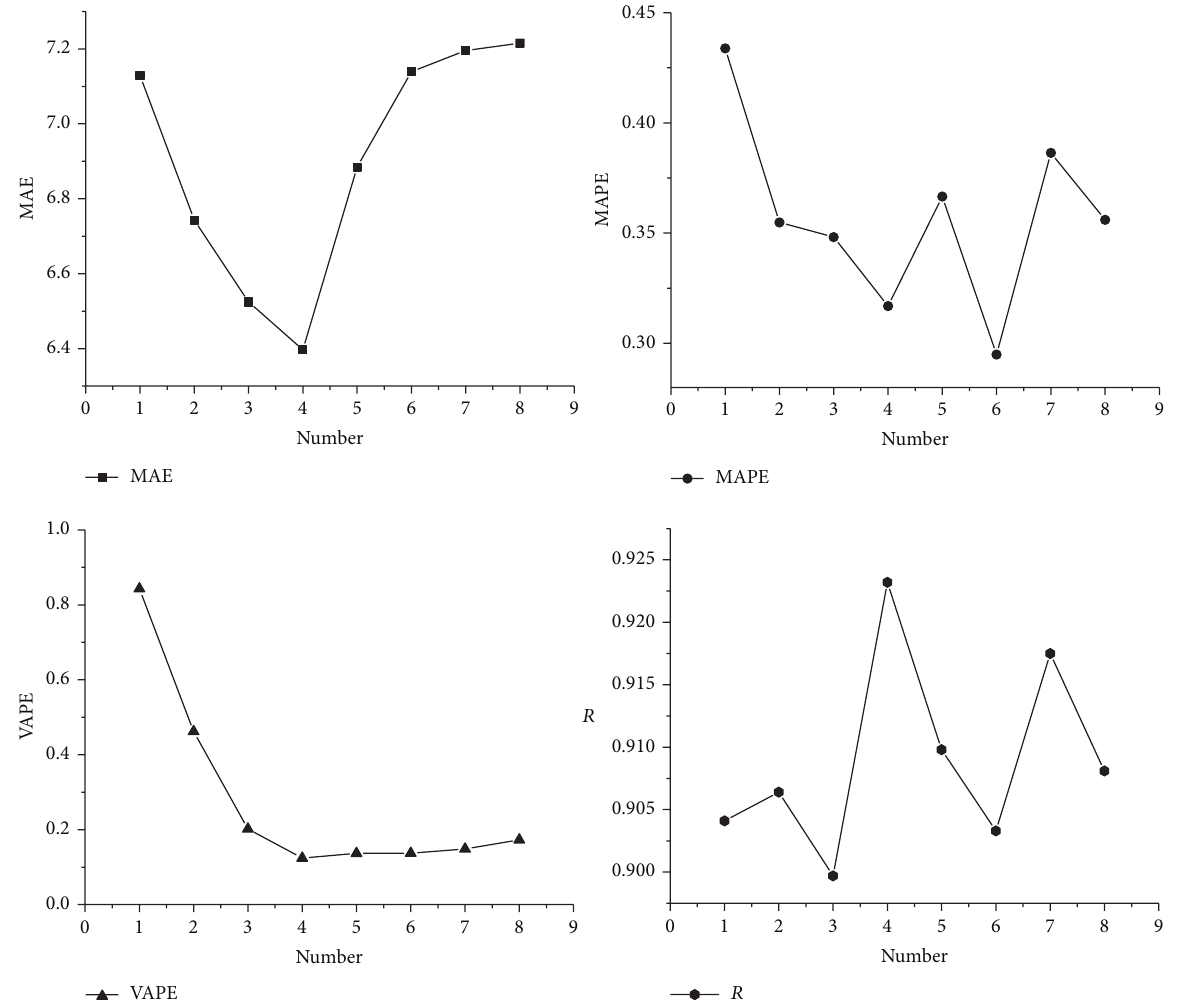
Figure 3: Trends of performance criteria of WNNMs with different number of input neurons.